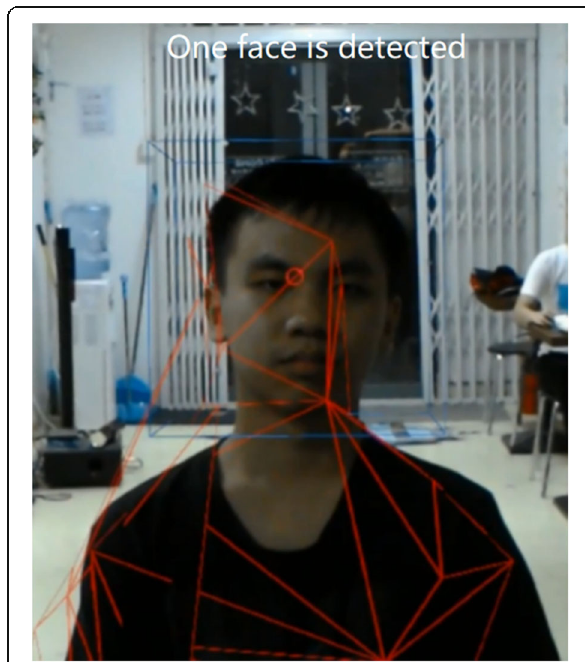
Fig. 14 Detection